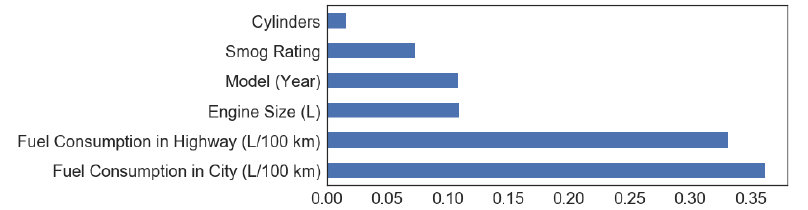
Figure 14. Importance of features on predicting CO 2